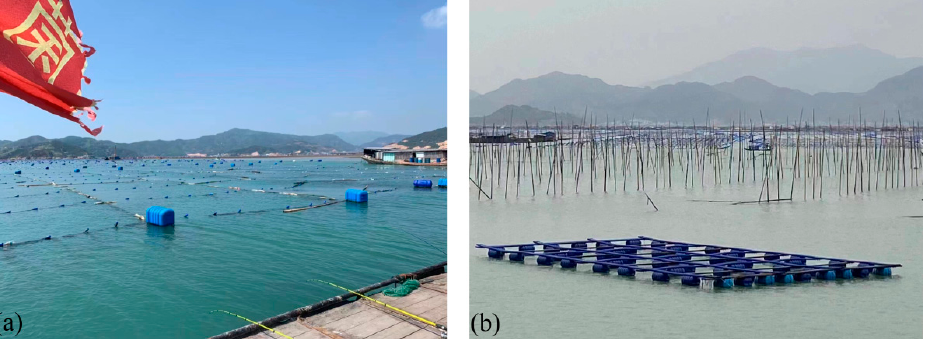
Figure 3. Ground images of marine ranching areas (Xiapu County, Ningde, 1 November 2022). ( a ) Floating raft aquaculture areas. ( b ) Cage aquaculture areas.